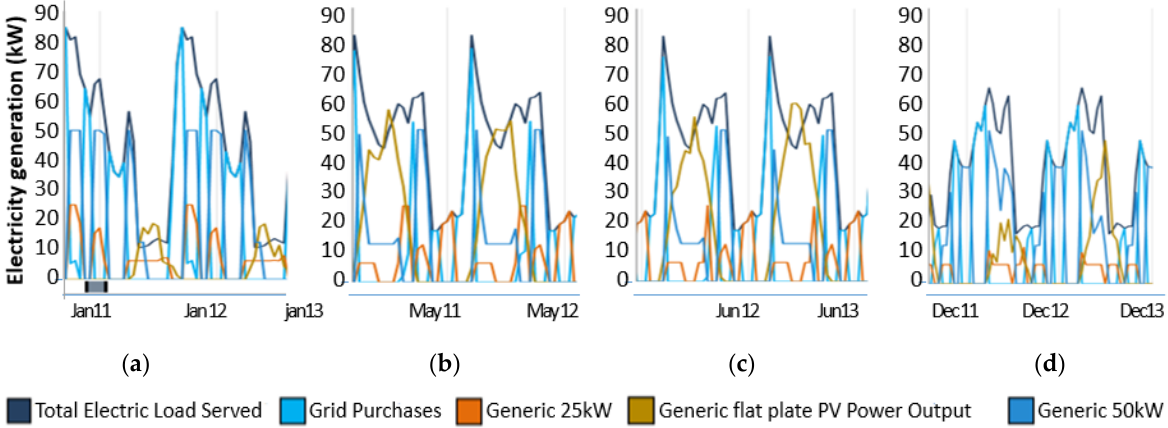
Figure 12. Electricity generation (Grid, PV, and biomass generic 25 kW, 50 kW) and total electrical load served on 11 January ( a ), 11 May ( b ), 11 June ( c ), and 11 October 2007 ( d ). Based on the calculation model provided in Section 3 that emanate from IEC 61724, In the case of 11 May and 11 June, the average solar irradiation between 6:00 and 18:00 was about 7.500 kWh/m 2 /day and 8.070 kWh/m 2 /day, and therefore, the PV array’s energy production was the highest of the renewable fraction. The average irradiation in October is 4670 kWh/m 2 /day and the consumption rate is relatively low. Grid purchased gard to the production and the consumption rate over four seasons.